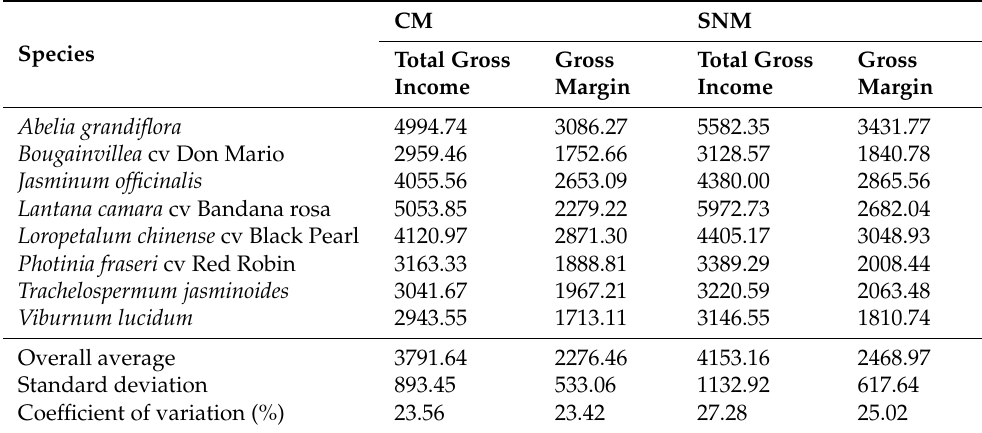
Table 11. Annual average total gross income and annual average gross margin (in EUR) associated with two production models: conventional production model (CM) and novel and sustainable production model (NSM), among 8 selected ornamental species.